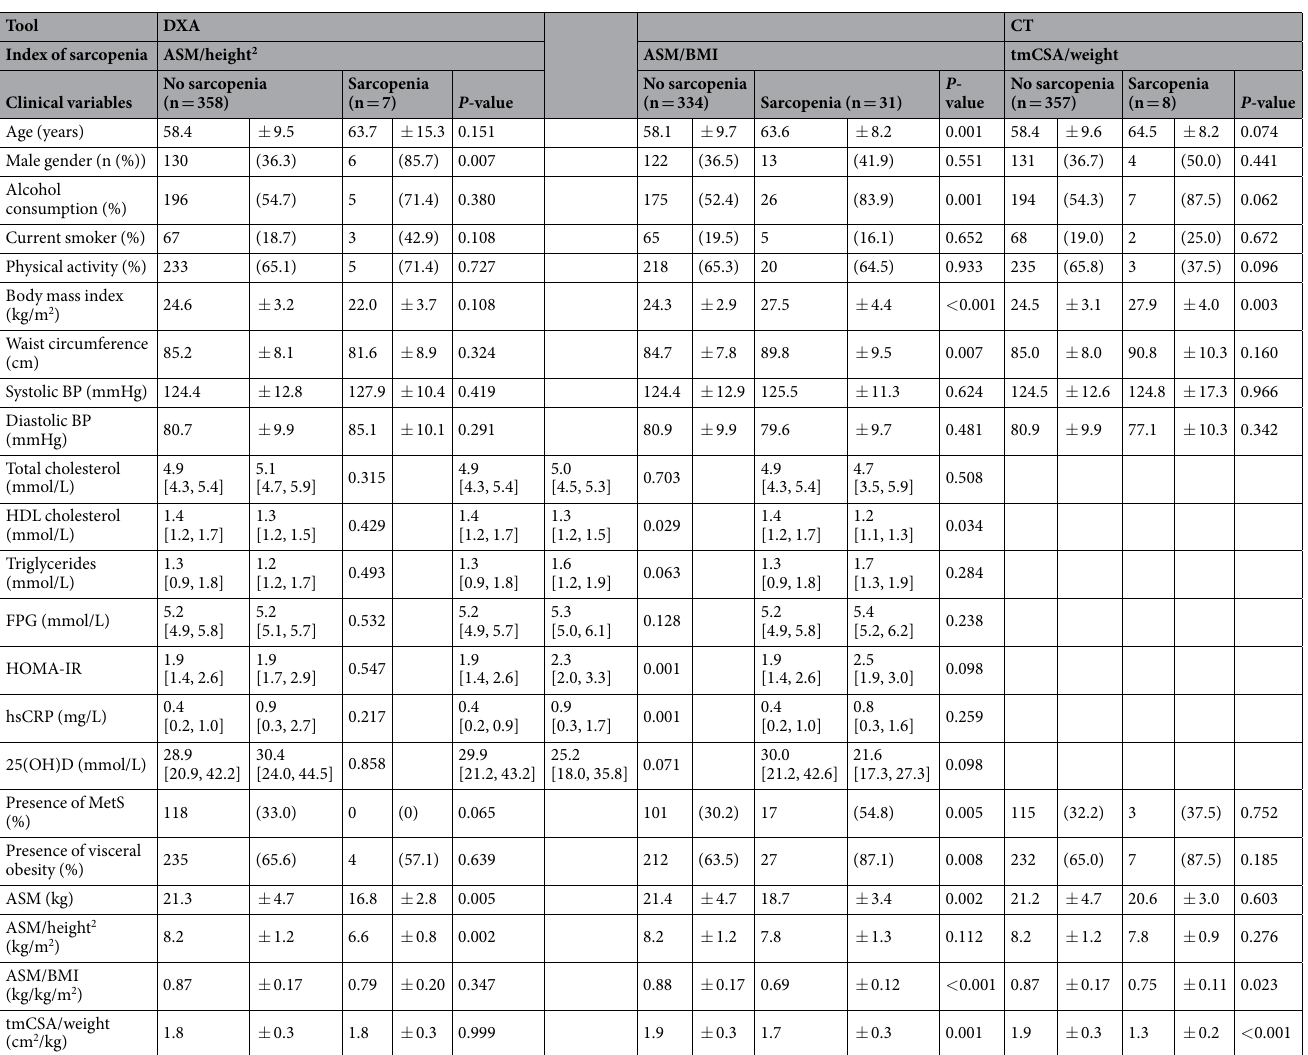
Table 1. Clinical characteristics of study subjects stratified by sarcopenia defined using DXA and CT. 25[OH] D, 25-hydroxyvitamin D; ASM, appendicular skeletal muscle mass; BMI, body mass index; BP, blood pressure; FPG, fasting plasma glucose; HDL, high-density lipoprotein; HOMA-IR, homeostasis model assessment of insulin resistance; hsCRP, high-sensitivity C-reactive protein; LDL, low-density lipoprotein; MetS, metabolic syndrome; tmCSA, thigh muscle cross-sectional area. Data are presented as mean ± SD, median [inter-quartile range] or n (%), as appropriate. P -values represent differences between sarcopenia and non-sarcopenia as determined by Student’s t-test or Wilcoxon rank test for continuous variables, and Fisher’s exact test or Pearson’s Chi-square test for categorical